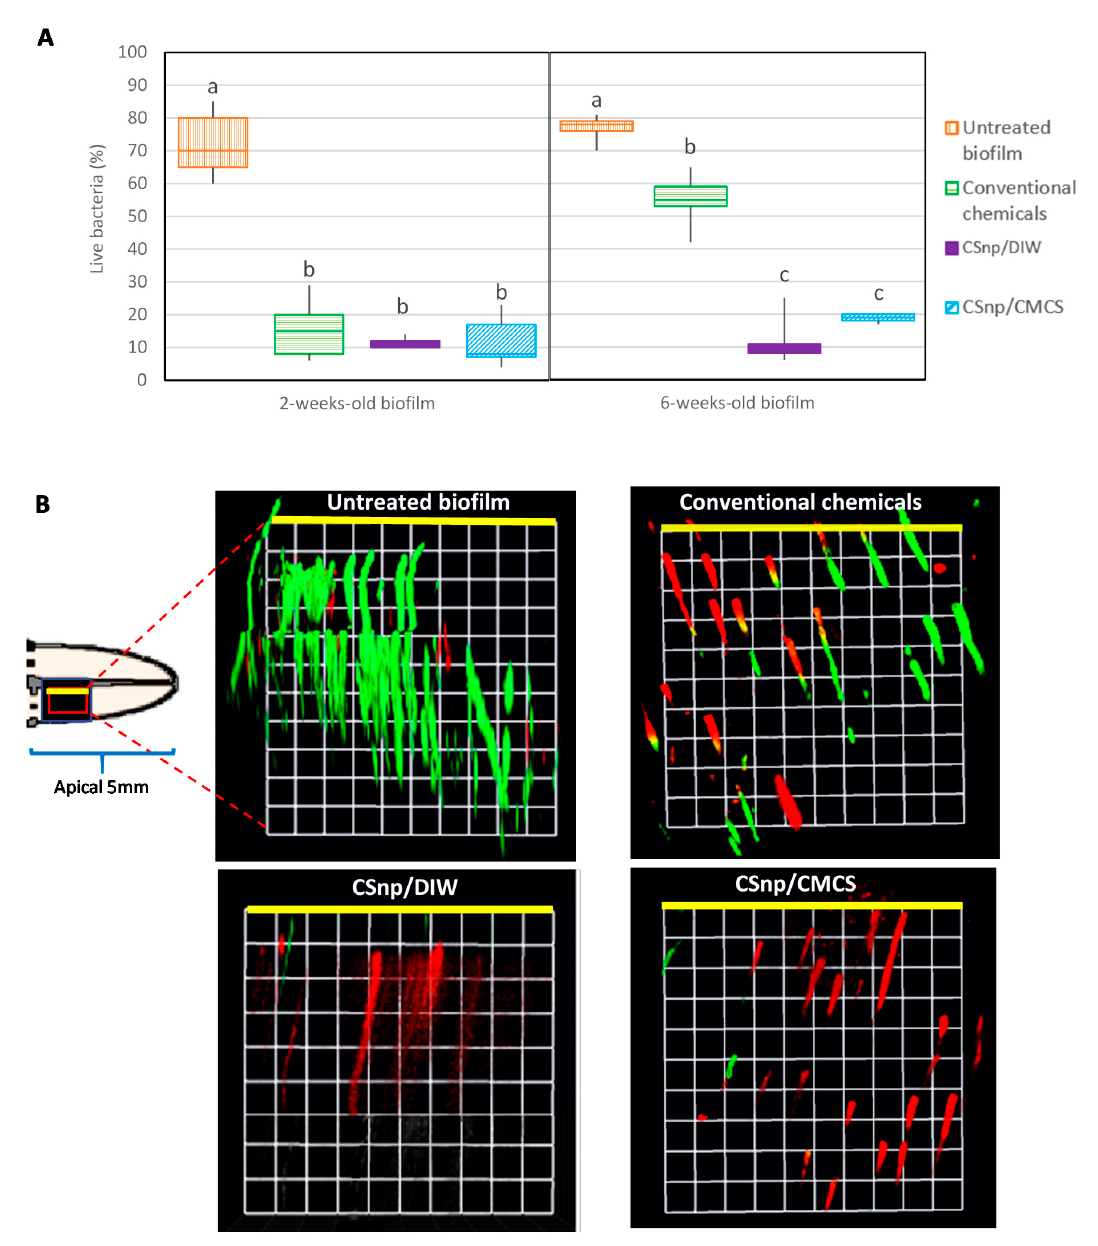
Figure 2. ( A ) Confocal laser scanning microscopy evaluation of antibacterial efficacy of CSnp/CMCS and CSnp/DIW versus conventional chemicals on 2- and 6-week-old E. faecalis biofilm showing percentage of live bacteria. Different characters above bars indicate statistically significant difference between the groups ( p < 0.01). ( B ) Confocal images of live/dead stained bacteria in root canal dentinal tubules of untreated and treated 6-week-old E. faecalis biofilm (green color: live bacteria, red color: dead bacteria, 40× magnification, 1 unit = 11.52 μ m), the yellow line represents the interface between root canal lumen and the dentinal tubules in root canal wall.